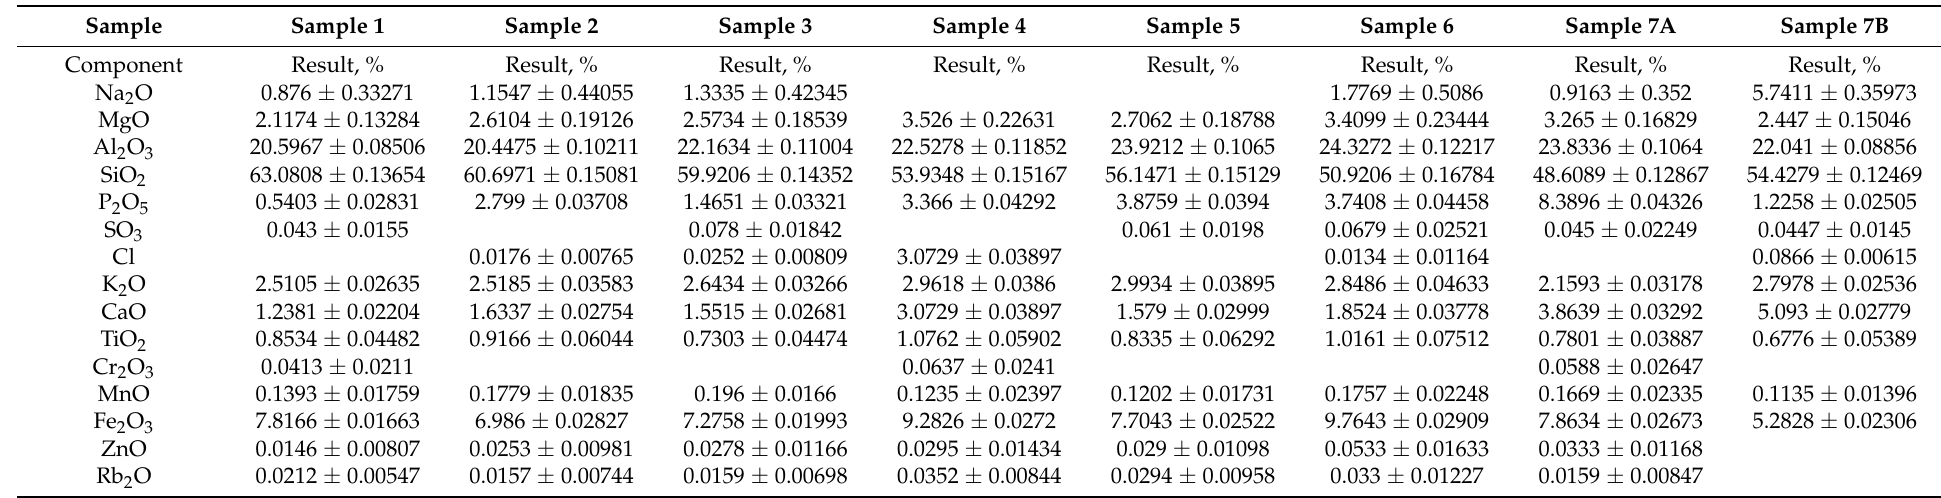
Table 2. Mineral composition (WDXRF) of the pottery fragments, expressed in mass% ± SD%, normalized to 100%